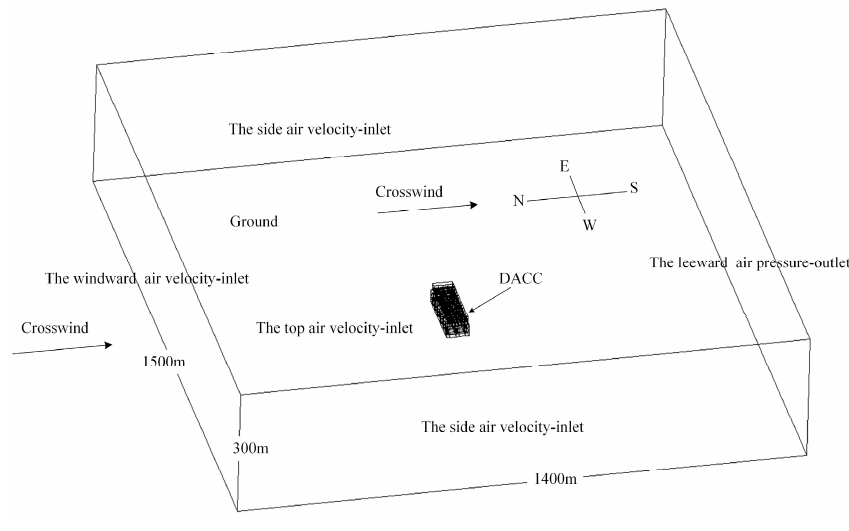
Figure 4. Calculation domain diagram.